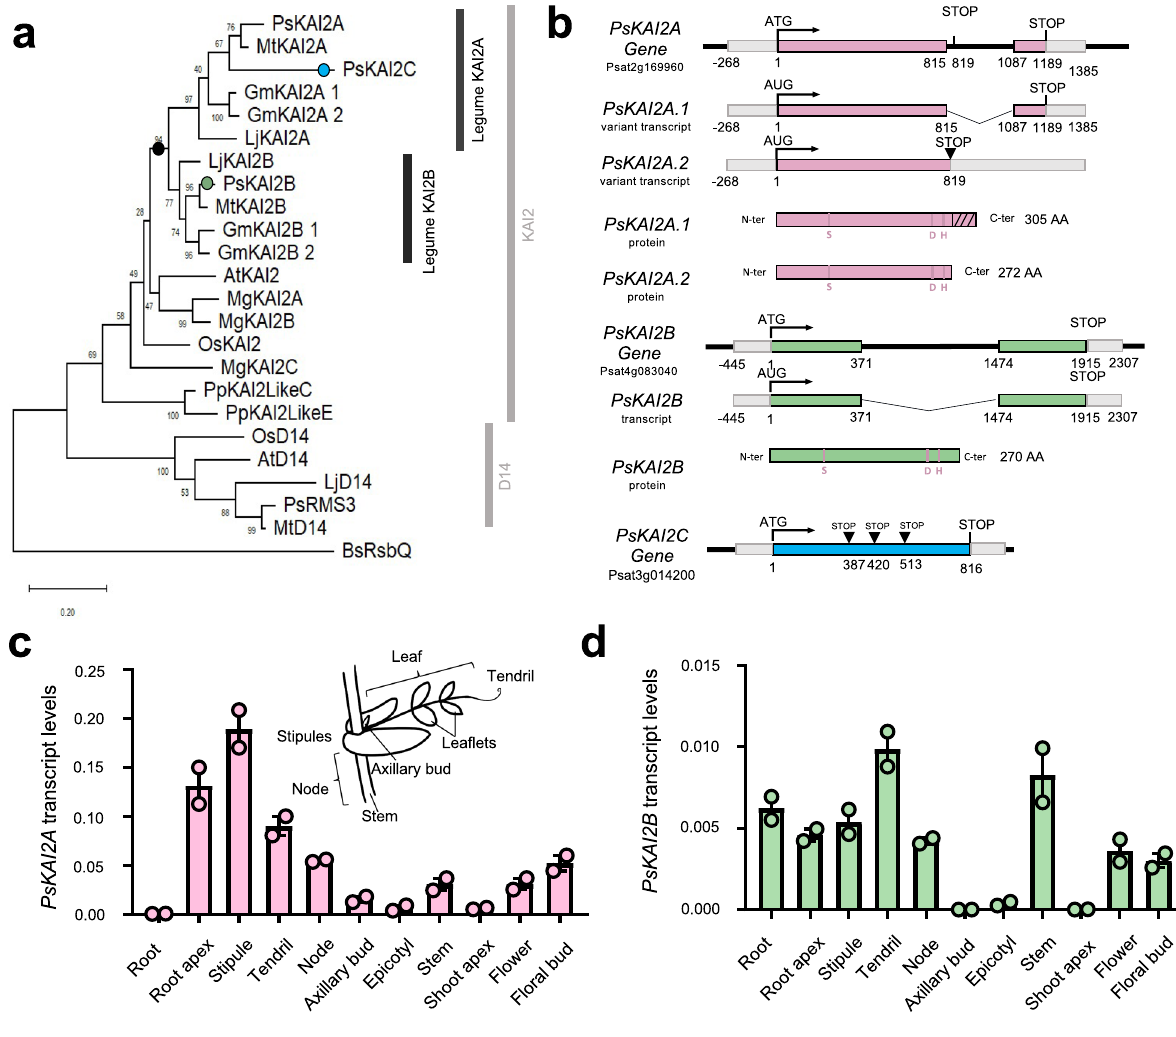
Fig. 1 Evolutionary analysis and differential expression of the legume Pisum sativum KAI2s. a Maximum likelihood phylogeny of 24 representative KAI2 amino acid sequences. Node values represent percentage of trees in which the associated taxa clustered together. Vertical rectangles highlight distinct KAI2 family clades. Black circle indicates legume duplication event. Pink, green, and blue circles mark the position of PsKAI2As, PsKAI2B, and PsKAI2C respectively. The tree is drawn to scale, with branch lengths measured in the number of substitutions per site. b PsKAI2A, PsKAI2B and PsKAI2C are homologs to AtKAI2 and encode α - β /hydrolases. Schematic representation of the PsKAI2A, PsKAI2B and PsKAI2C genes; Exons are in pink, green and blue lines, non-coding sequences colored in thin black lines and UTR regions shown as thick gray lines. Bases are numbered from the start codon. PsKAI2A shows 2 splicing variants. Spliced introns are shown as bent ( “ V ” ) lines. Inverted triangle ( ▼ ) indicates premature termination codons. Catalytic triad residues are indicated in pink. The hatched part indicated the C-terminus extension of the PsKAI2.1 protein ( c , d ) Differential expression pattern of PsKAI2A ( c , pink) and PsKAI2B ( d , green). Transcript levels in the different tissues of 21 old wild-type Pisum sativum plants (cv. Terese) were determined by real-time PCR, relative to PsEF1 α . Data are means ± SE ( n = 2 pools of 8 plants). Inset drawing of a node showing the different parts of the pea compound